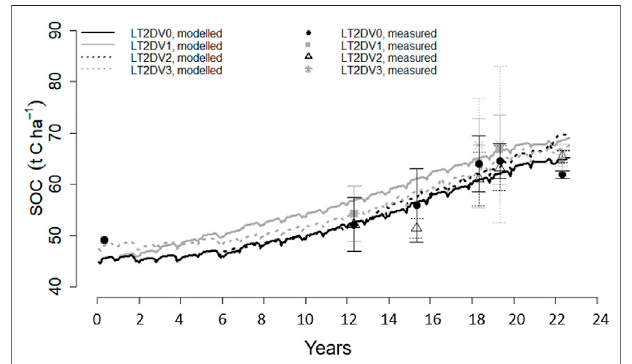
FIGURE 4 | Measured (point) and modeled (line) SOC in Foggia (Italy) arable cropland site, LT2, under conventional (LT2DV0), diversi fi cation 1 (LT2DV1), diversi fi cation 2 (LT2DV2), and diversi fi cation 3 (LT2DV3) for the period 1996 – 2018 at 0 – 30 cm depth (The fi eld experimental period of LT2DV2 and LT2DV3 is 2010 – 2018). The error bar indicates standard deviation of the measured SOC. Please note that the simulated and experimental values of LT2DV2 slightly overlap with those of LT2DV0.